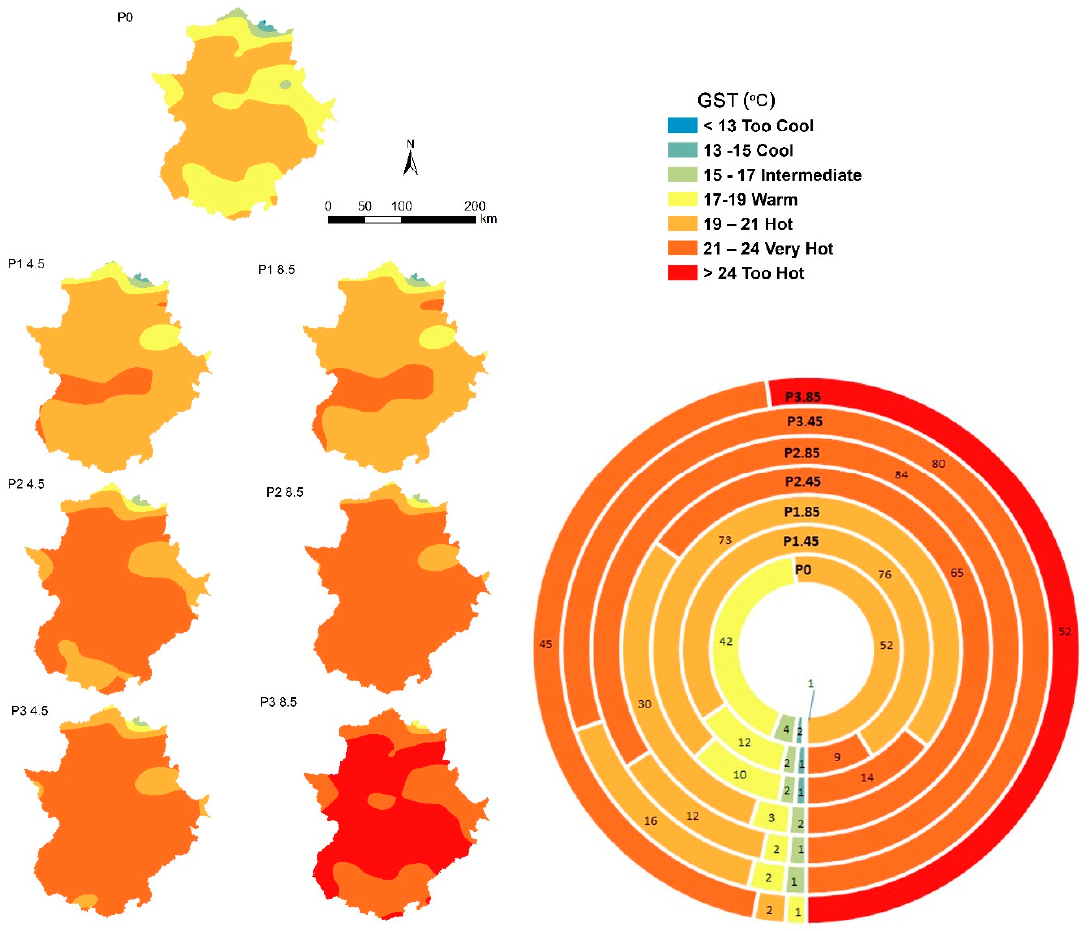
Figure 4. Spatial distributions of GST during the historical period (P0) and the future time periods (P1, P2 and P3) in Extremadura. The percentages of each GST class for all time periods and under both scenarios, RCP 4.5 and RCP 8.5, are also shown (for instance, P1.45 means the time period P1 under the scenario RCP 4.5).